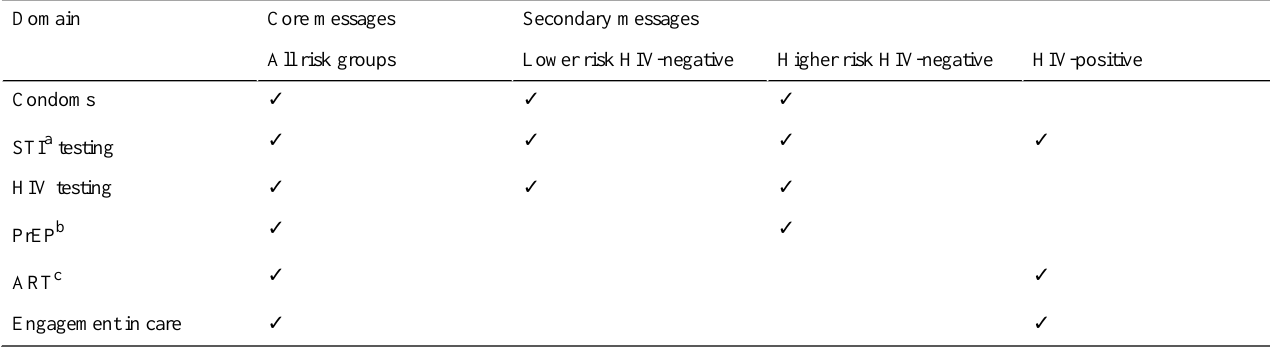
Table 1. M3 domains in the mobile